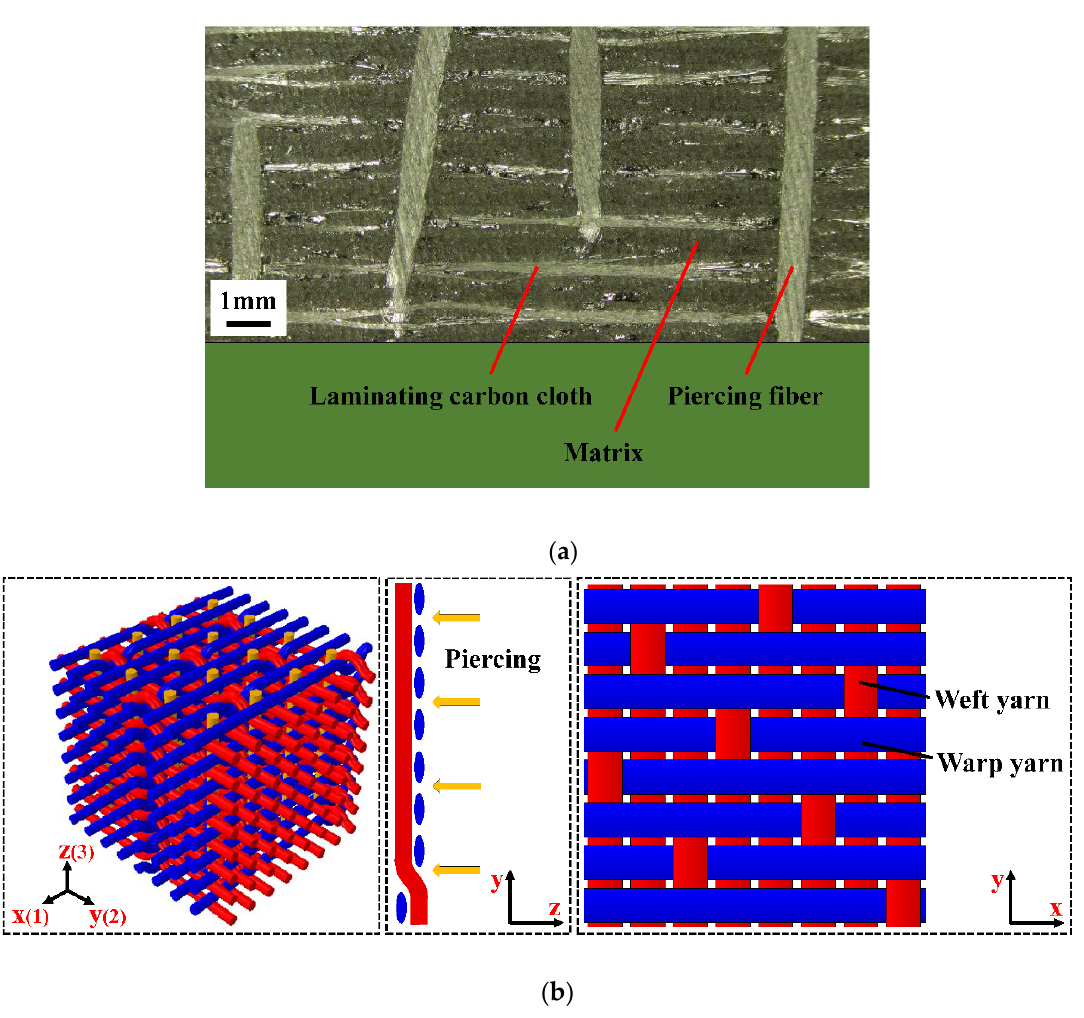
Figure 3. Layer structure of the C/C composites ( a ) and braiding pattern of the pre-fabricated part ( b ).